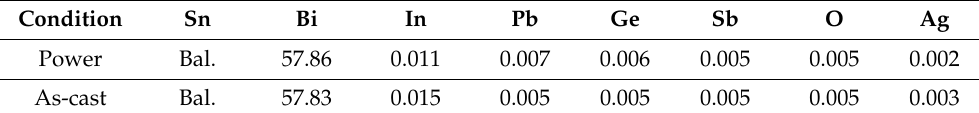
Table 1. Chemical compositions (wt%) of the Sn58Bi powder used and as-cast Sn58Bi alloy.